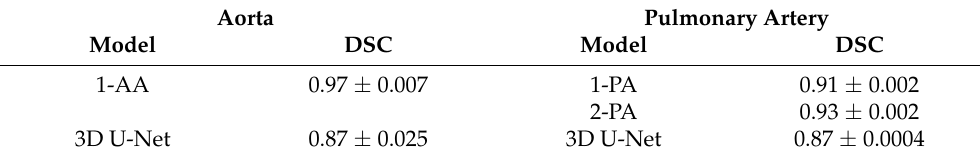
Table 2. Segmentation performance of the two-stage segmentation